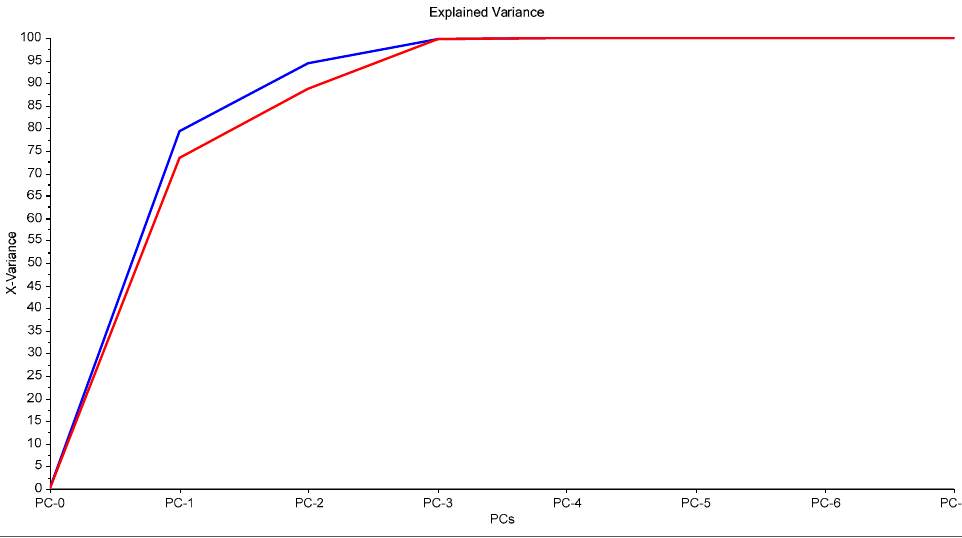
Figure 2. Principal component analysis for the system Dz-Hg(II).